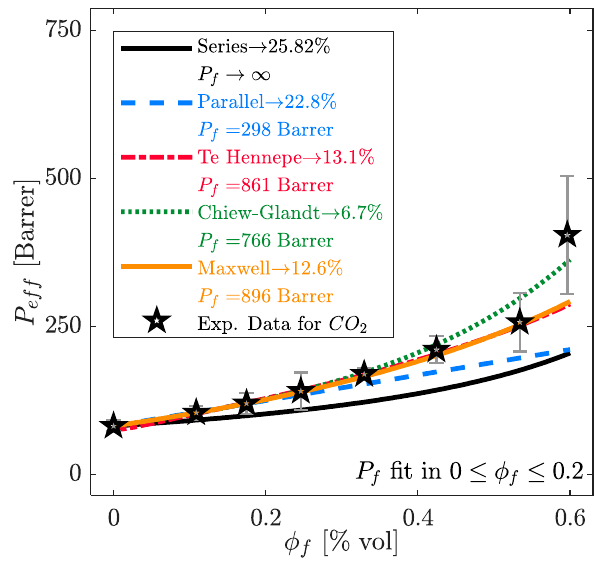
Figure 8. Comparison of resistance model approach (RMA)/effective medium approach (EMA) predictions for the filler phase permeability ( P f ) , obtained by fitting P ef f to experimental permeation data of CO 2 in Zeolite-13X/EPDM MMMs from [178], for filler fraction in the range 0 ≤ φ f ≤